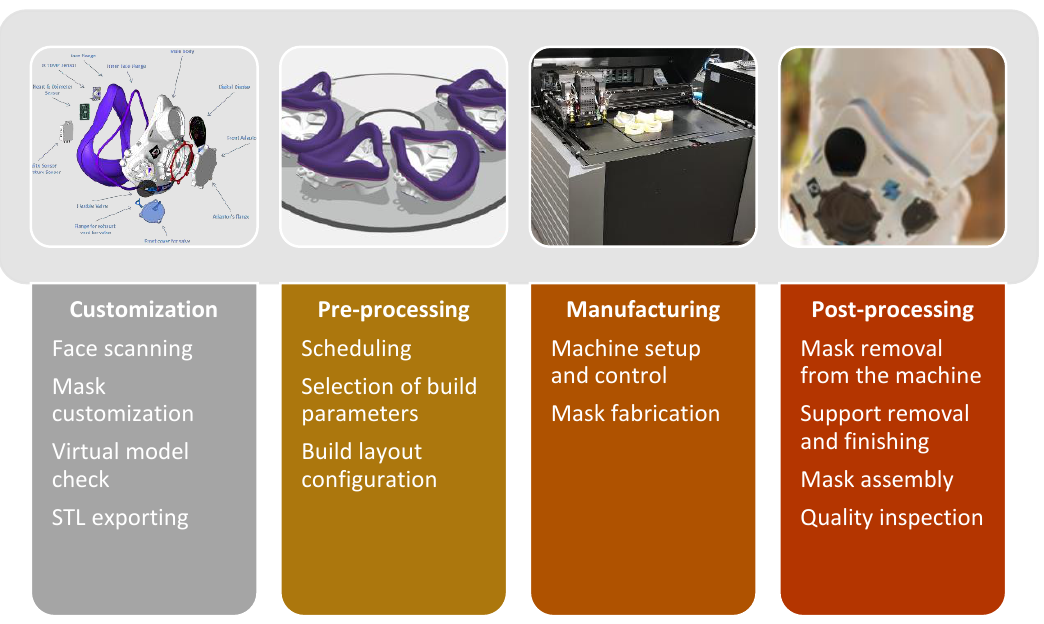
Figure 2. The four phases of the mask production process.